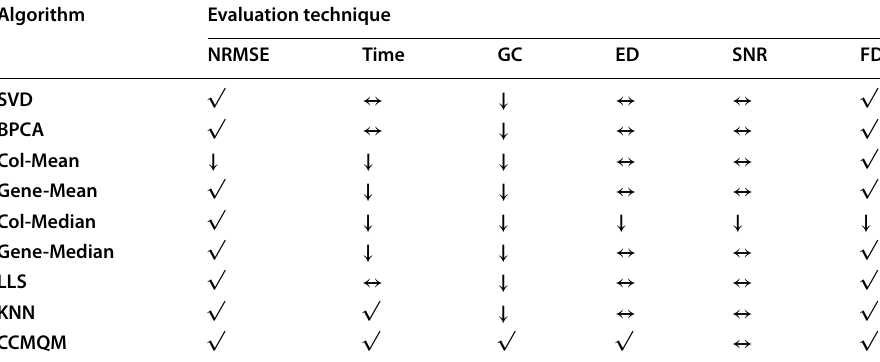
Table 2 Methods across evaluation techniques